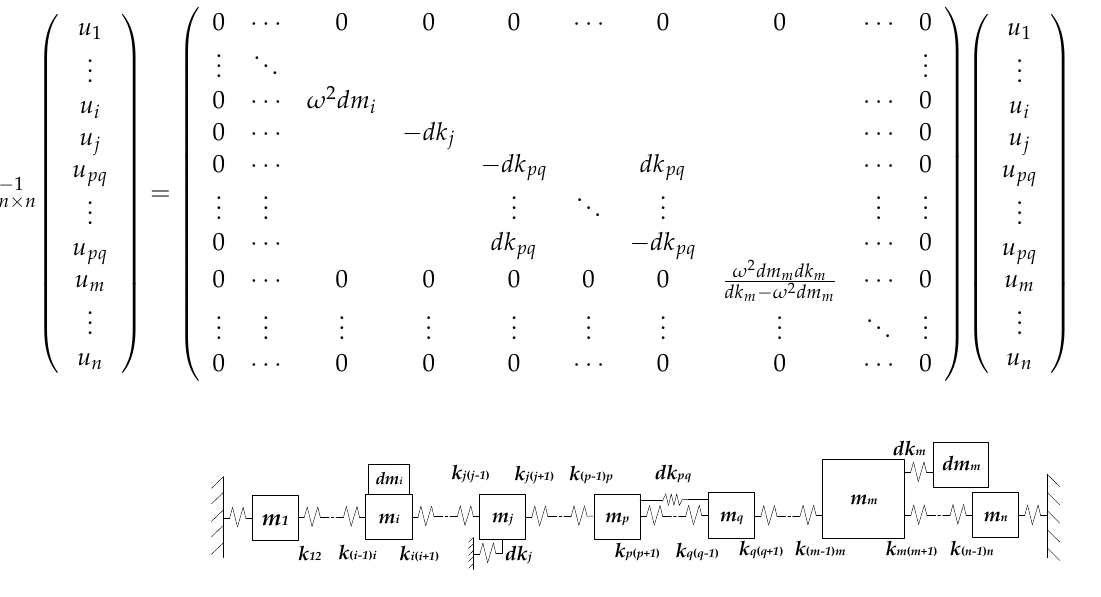
Figure 6. General structural modification.